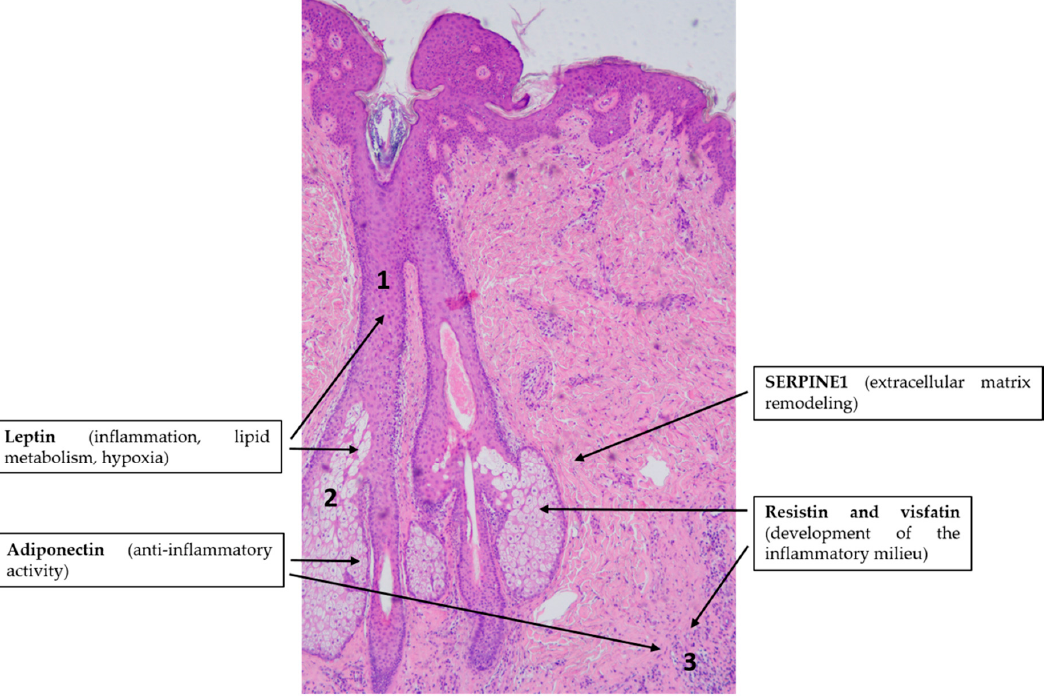
Figure 4. Adipokines might be involved in the pathogenesis of acne vulgaris. Note the simplified characteristic histopathological findings in acne: ductal hyperkeratosis (1), altered sebum production by sebocytes (2) and immune cell infiltration in the dermis (3). Hematoxylin eosin staining; original magnification: